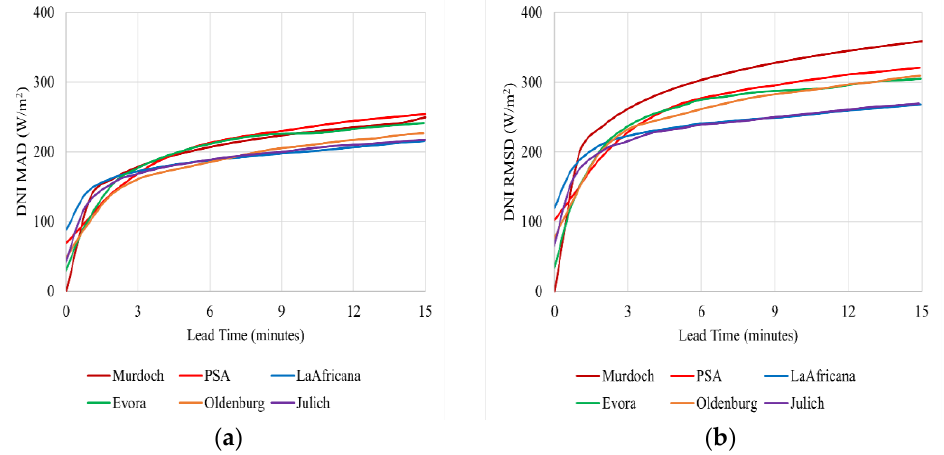
Figure 16. ( a ) DNI MAD for Intermittently Cloudy class. ( b ) DNI RMSD for Intermittently Cloudy class.